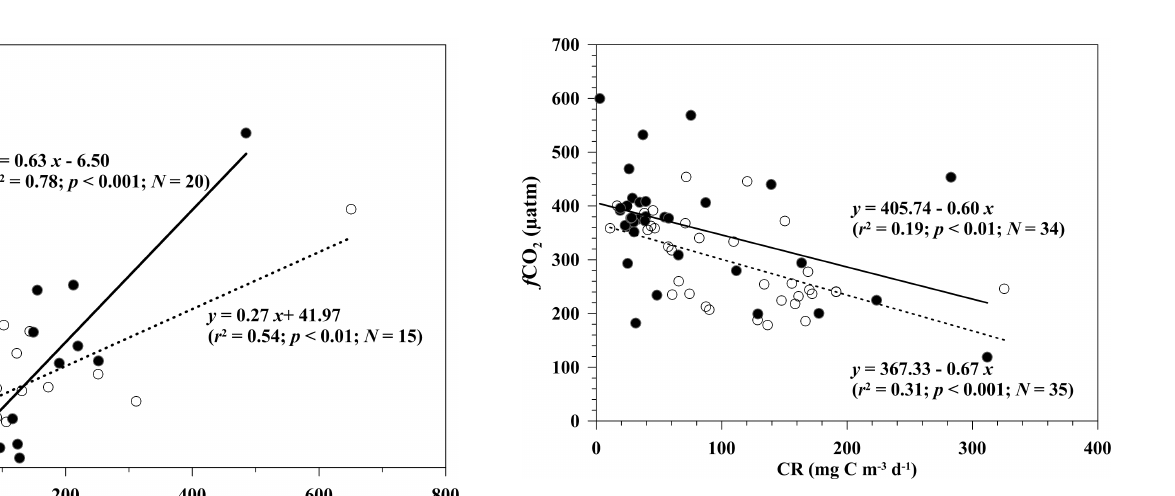
Figure 6. Relationships between the fugacity of CO 2 ( f CO 2 ) and plankton community respiration (CR) in the surface water in 2009 ( ◦ ; solid line) and 2010 ( • ; dashed line). The respective r 2 and p values are shown for each linear regression